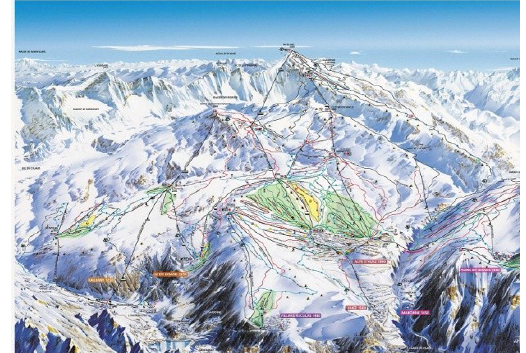
Figure 1. Alpes d’Huez ski trails maps, made by Atelier